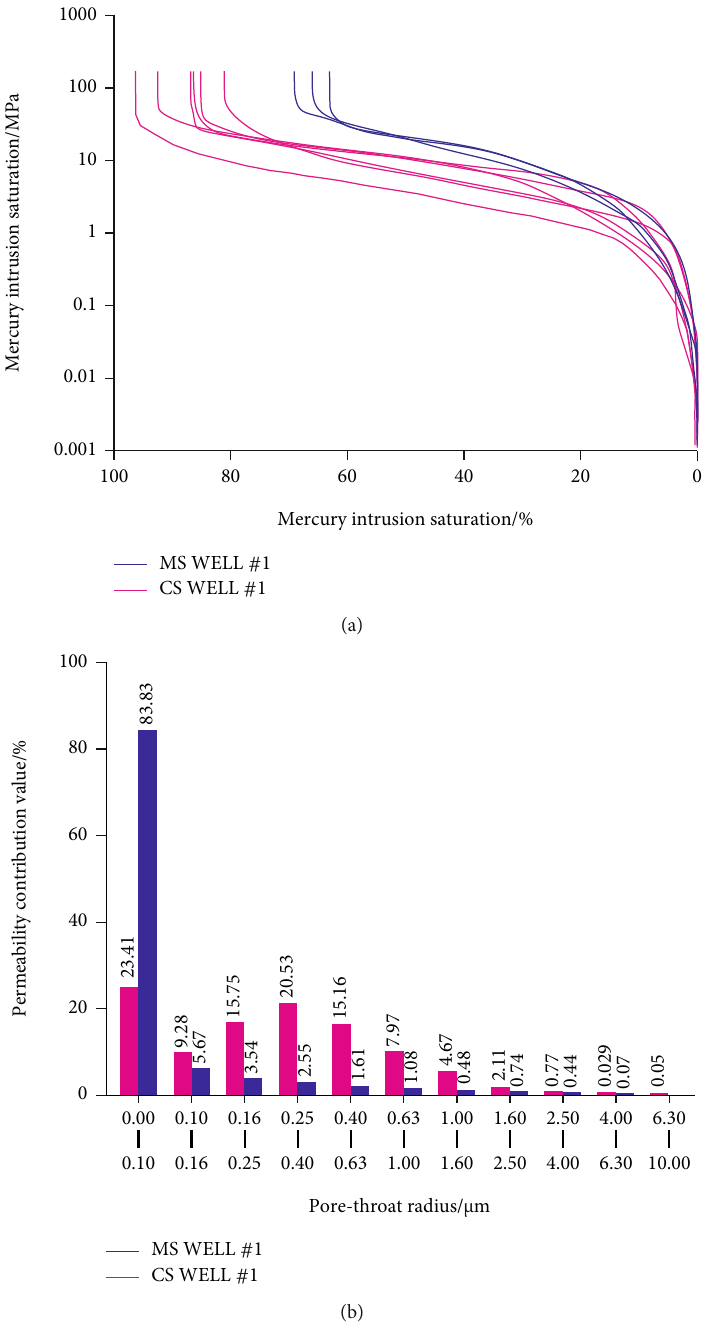
Figure 7: HPMI curves of C well #1 and MS1 well #1 Z (b) Histogram of pore-throat radius